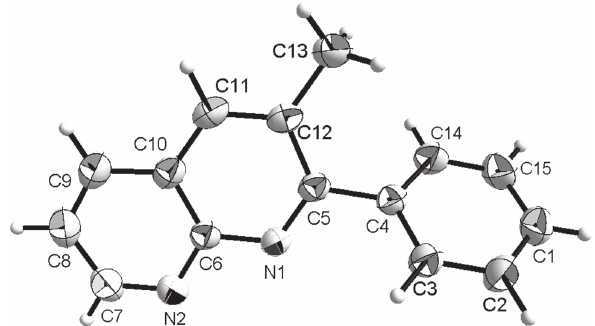
Table 1: Data collection and handling.